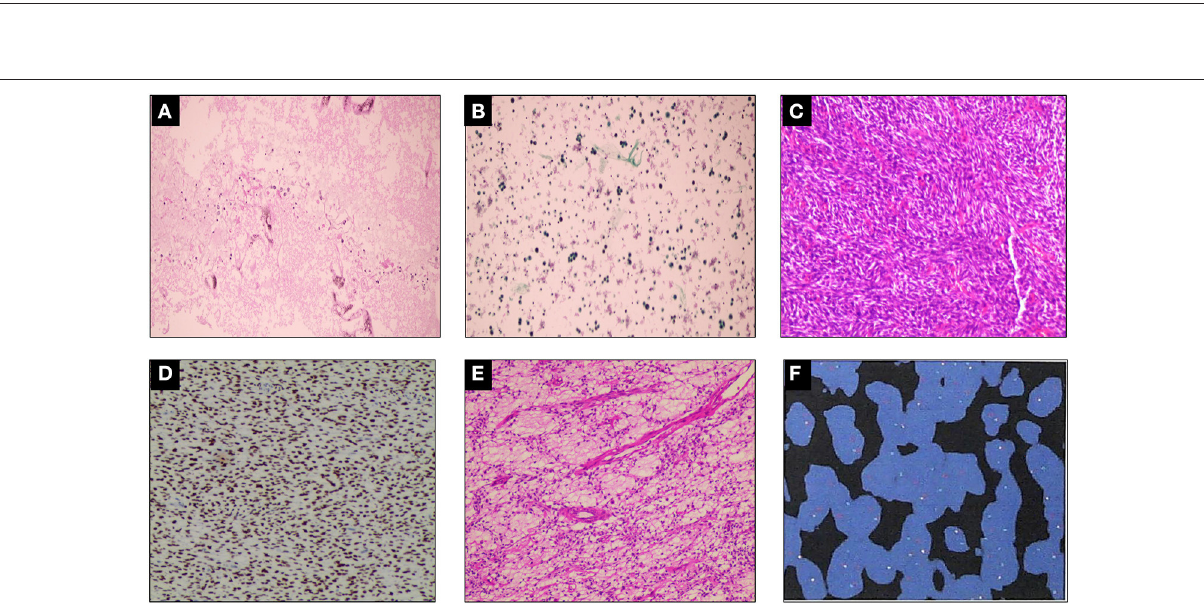
Frontiers in Cardiovascular Medicine |